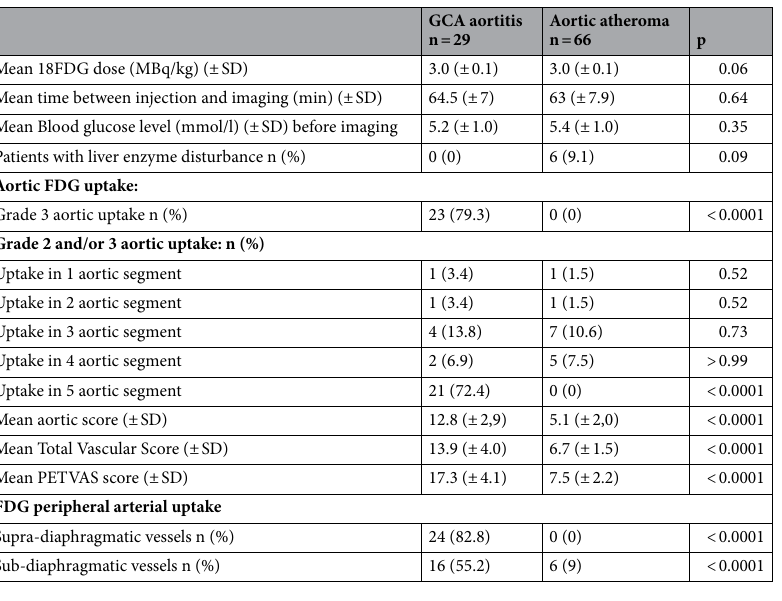
Table 1. FDG-PET/CT uptake patterns global comparison between aortitis and aortic atheroma